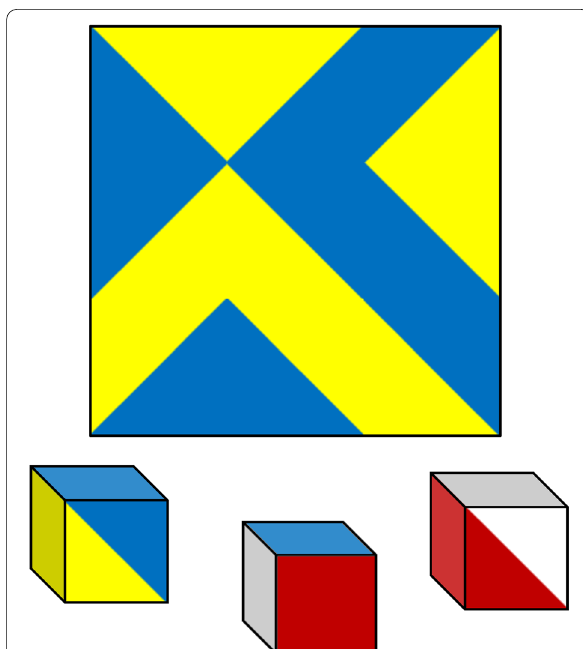
Fig. 2 Example item for a block design test. Note This item is from the original version of Kohs’ (1920) block design test. The target pattern, printed on a sheet of paper, has to be reproduced using cubes (whose sides are printed red, white, blue, yellow, red-and-white, and blue-and-yellow). The test is timed. Each design uses between 4 and 16 blocks (9 in the above example). Some designs are presented with the reference frame oriented as a